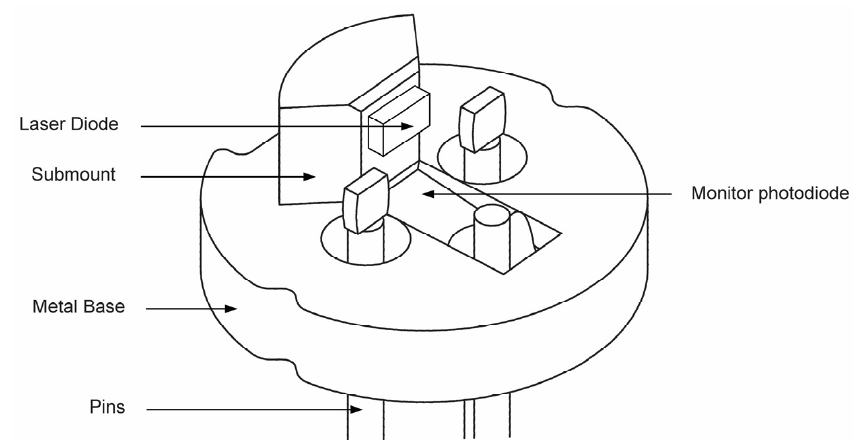
Figure 1. TO-can package of LD.